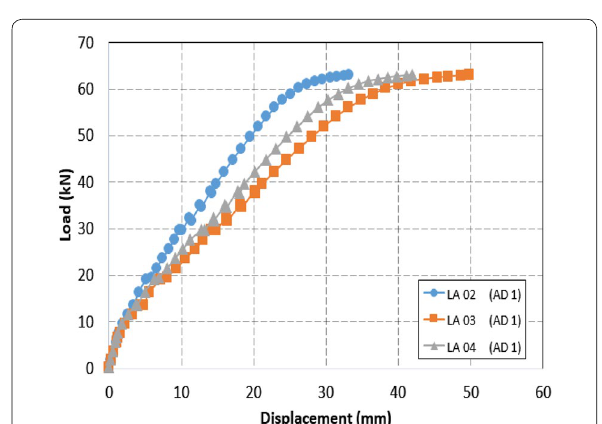
Fig. 7 AD load–displacement curve.